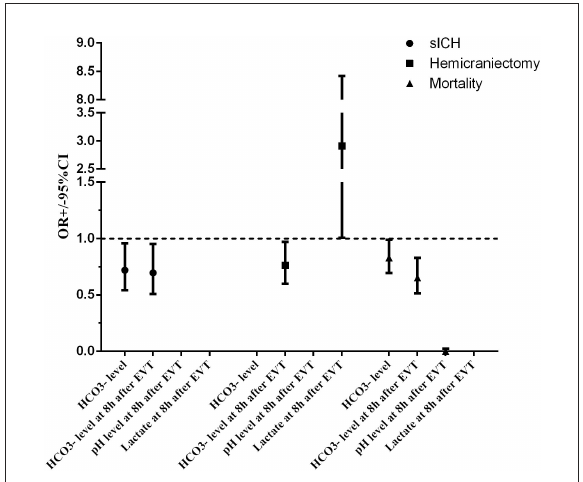
FIGURE2 Adjusted odds ratio (OR, midpoints) and 95% CIs (error bars) derived from multivariable analysis for clinical outcomes of patients with endovascular thrombectomy. ASPECTS, Alberta stroke program early CT score; CI, confidence interval; EVT, endovascular thrombectomy; HCO 3 − , bicarbonate; NIHSS, national institutes of health stroke scale; OR, odds ratio; sICH, symptomatic intracranial hemorrhage.